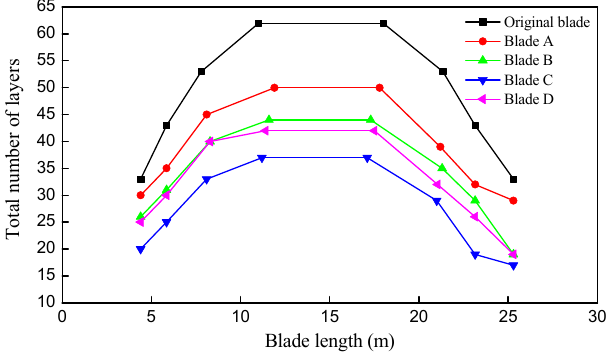
Figure 19. Comparison of total material layup of the spar cap.